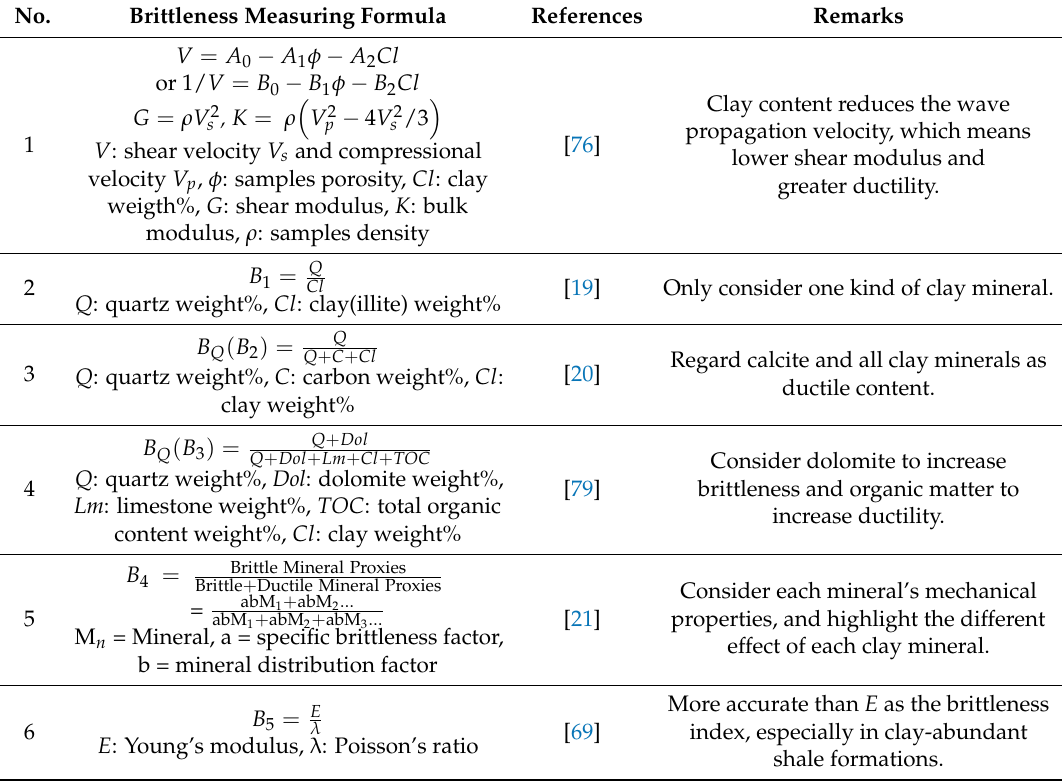
Table 3. Brittleness indices in research literature considering the clay